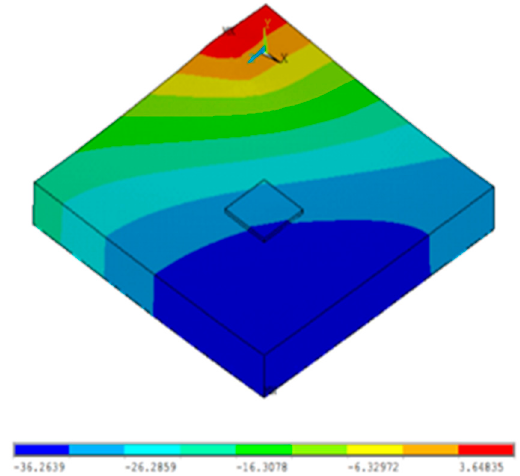
Figure 15. Deformation shape of UN slab.